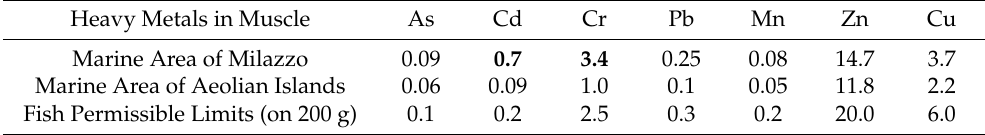
Table 3. Permitted limits of heavy metal concentrations over 200 mg in the kidney of Boops boops